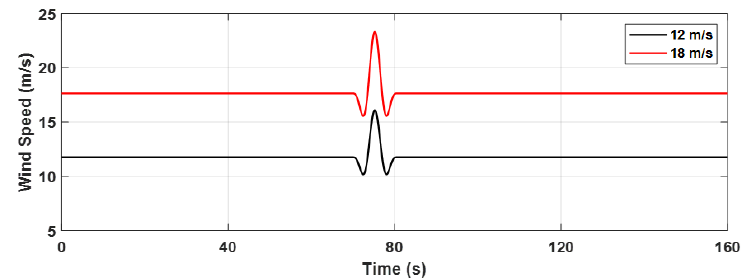
Figure 9. Time-domain diagram at 12 m/s and 18 m/s in EOG.